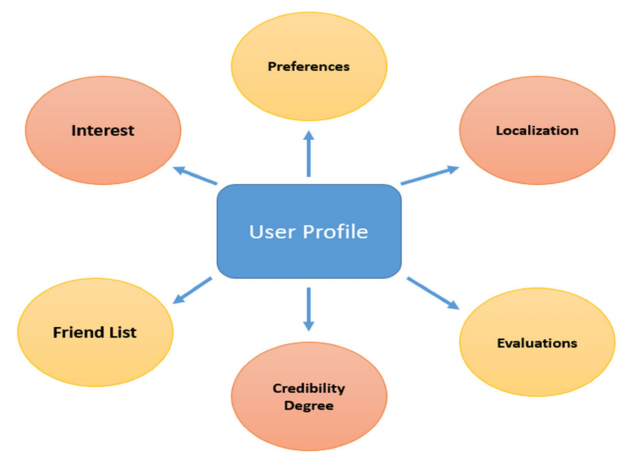
Figure 1. The components of user’s profile.